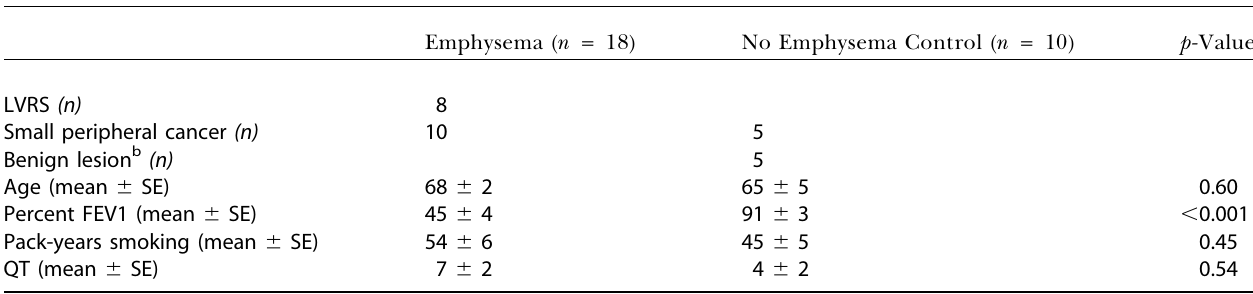
Table 1. Clinical and Demographic Characteristics of Participants